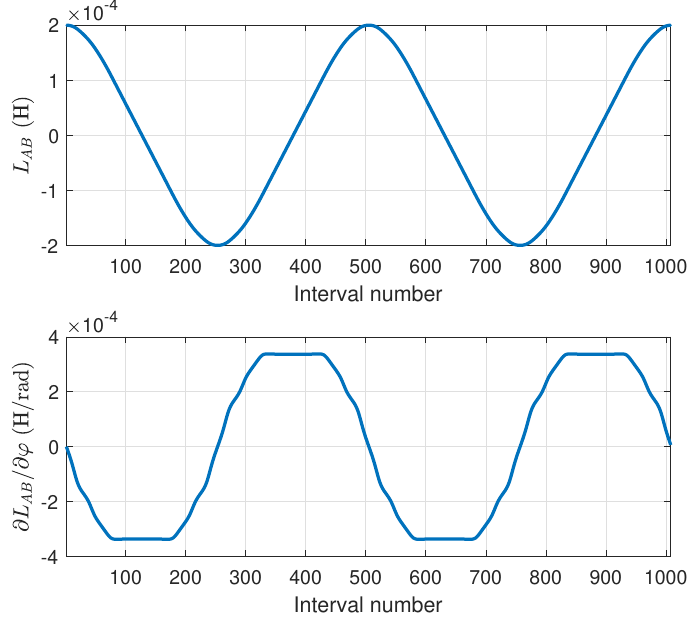
Figure 13. Mutual inductance between a stator phase and rotor bar of the simulated machine as a function of the rotor position ( top ), and its angular derivative ( bottom